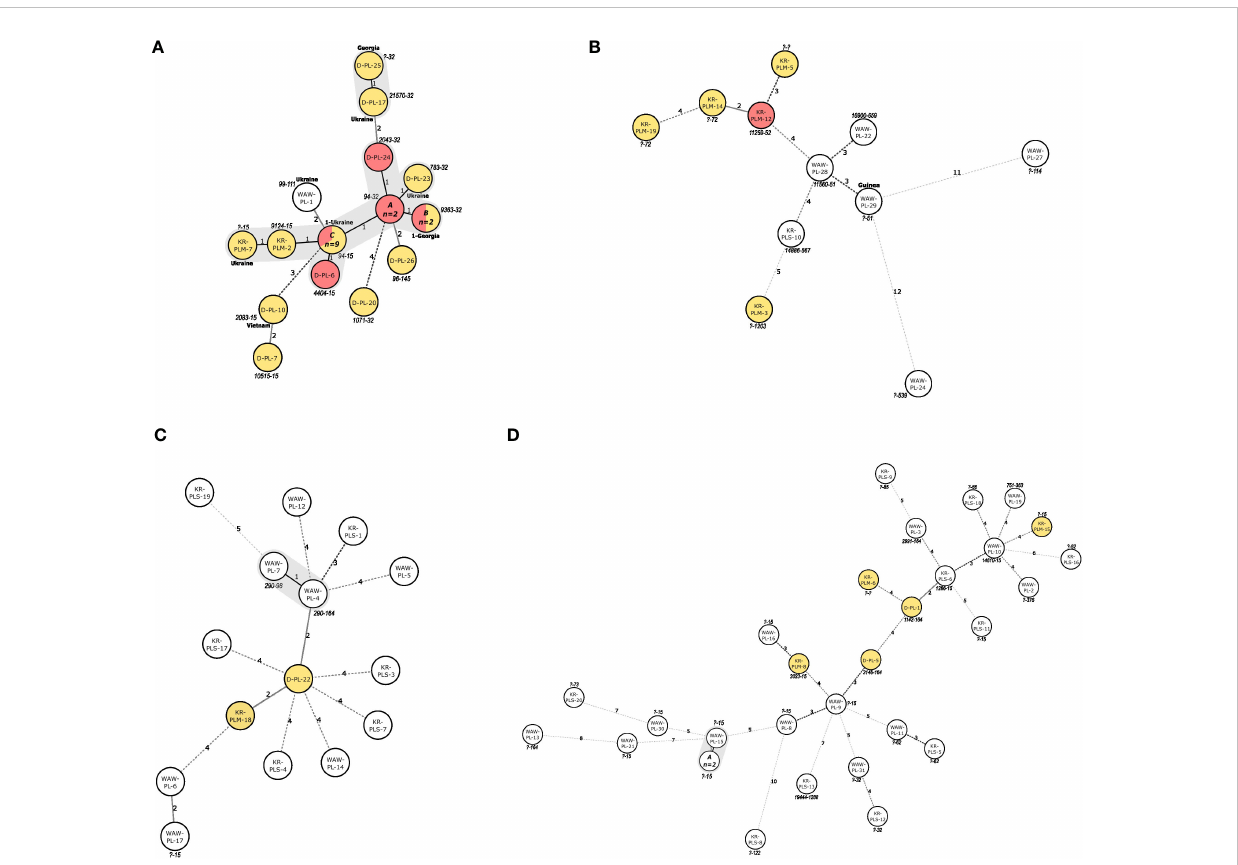
FIGURE 1 (A – D) . Minimum spanning trees illustrating the potential evolutionary relationships of the M. tuberculosis isolates of (A) Beijing, (B) LAM, (C) Haarlem and (D) L4-unclassi fi ed families, identi fi ed in this study. The lengths of the branches indicate the levels of changes on MIRU-VNTR-code. Solid lines represent a single or double change, while dotted lines represent 3 or more changes (a precise number of changes is indicated on the line). For foreign-born patients ’ country of birth is shown next to the node. MDR-isolates are marked in yellow, pre-extensively drug resistant isolates are marked in red. Isolates IDs are marked within circles. MLVA types are markes next to the circles. SLVs are marked with grey shading. ID of isolates within the nodes of panel (A) (MLVA 94-32): A: D-PL-21, KR-PLM-11; C: (MLVA type 9363-32): KR-PLM-13, KR-PLM-9; C: (MLVA 94-15): D-PL-11, D- PL-12, D-PL-13, D-PL-14, D-PL-2, D-PL-4, D-PL-8, D-PL-9, KR-PLM-4. ID of isolates within the nodes of Panel (D) (?-15): A: WAW-PL-18, WAW-